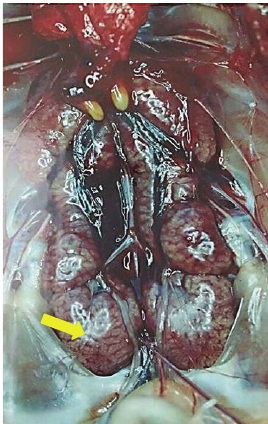
Figure 5: Gross lesions in kidney of chicken following experimental infection with a nephropathogenic infectious bronchitis virus. Note: swelling and congestion of the kidney (arrow) (courtesy: Siti Suri Arshad).